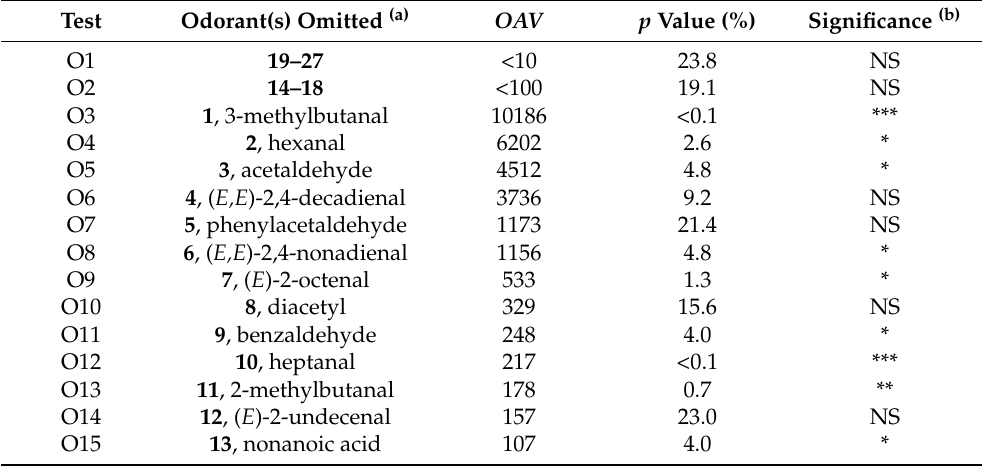
Table 4. Omission experiments applied to the aroma model of pea protein